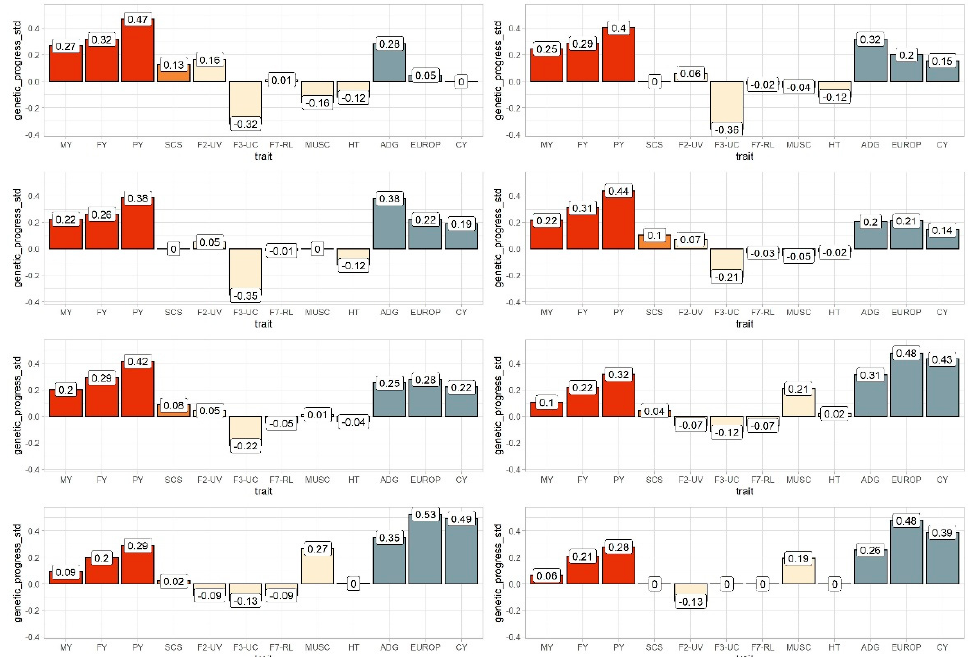
Figure 2. Standardized genetics progress (y axes) for 12 traits studied considering 8 different scenarios (from S1 to S8) attributing different weights to specific traits in the possible selection index. Red bars represent milk, fat, and protein, orange bars SCS, light-yellow morphological traits (both factors and single trait analyzed), and grey bars beef traits (type rear muscularity or performance test traits). Traits’ abbreviations are reported in Table 1.